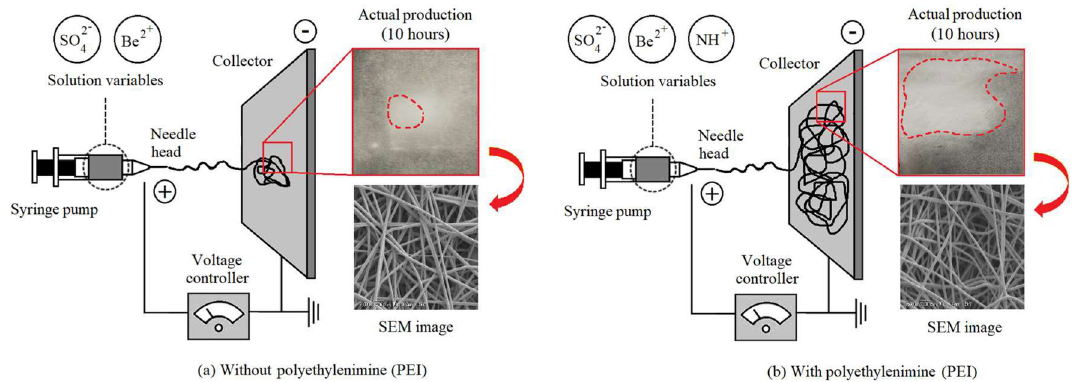
Fig. 3 The productivity of precursor nanofibers after 10 hours ( a ) without PEI and ( b ) with